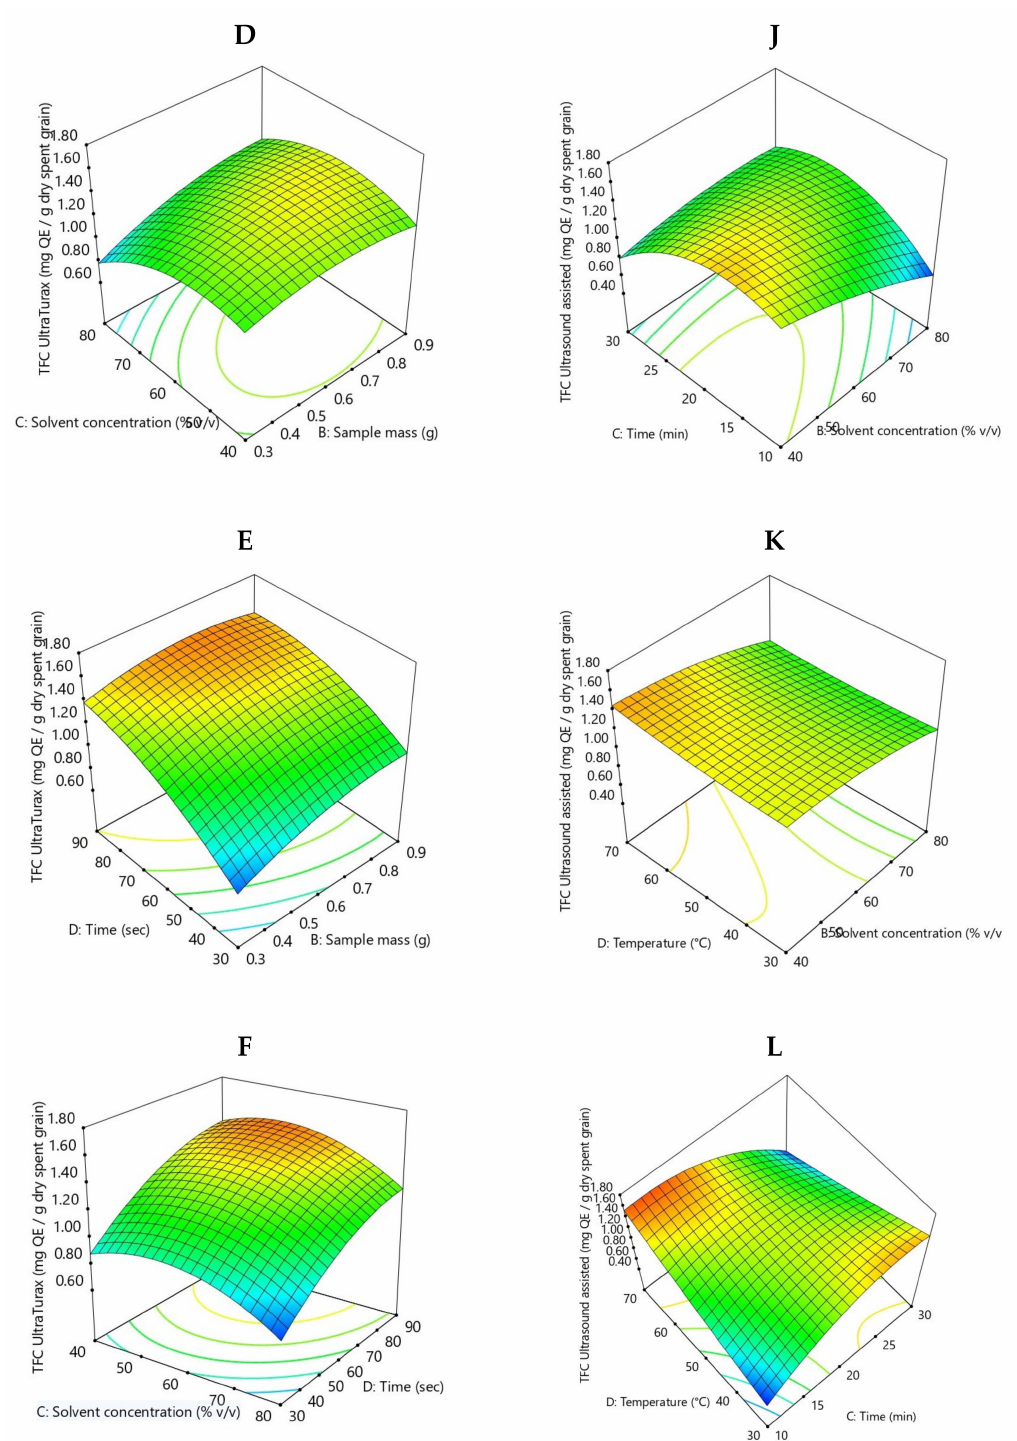
Figure 3. Response surface plots showing the effect of extraction parameters on flavonoid content for SG Ultra-Turrax pre-treatment ( A – F ), and for ultrasound-assisted pre-treatment ( G – L